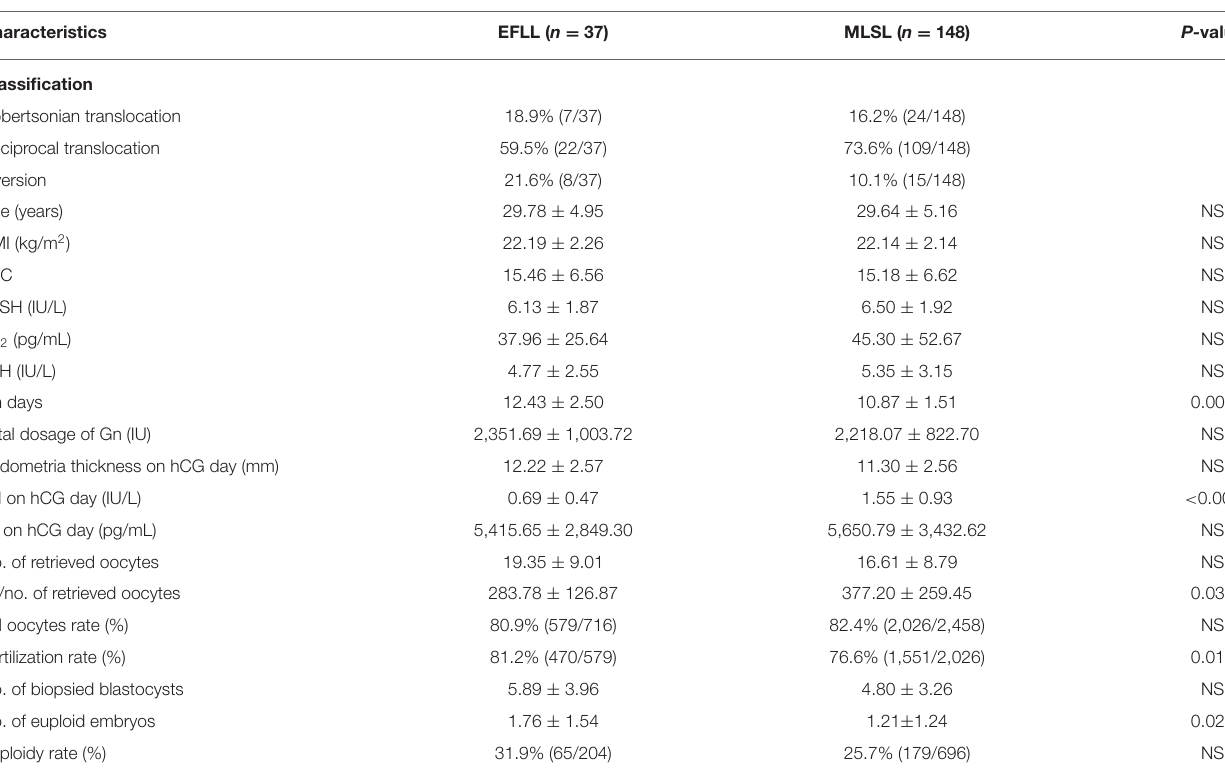
TABLE 2 | Baseline characteristics and outcomes of PGT-SR cycle.